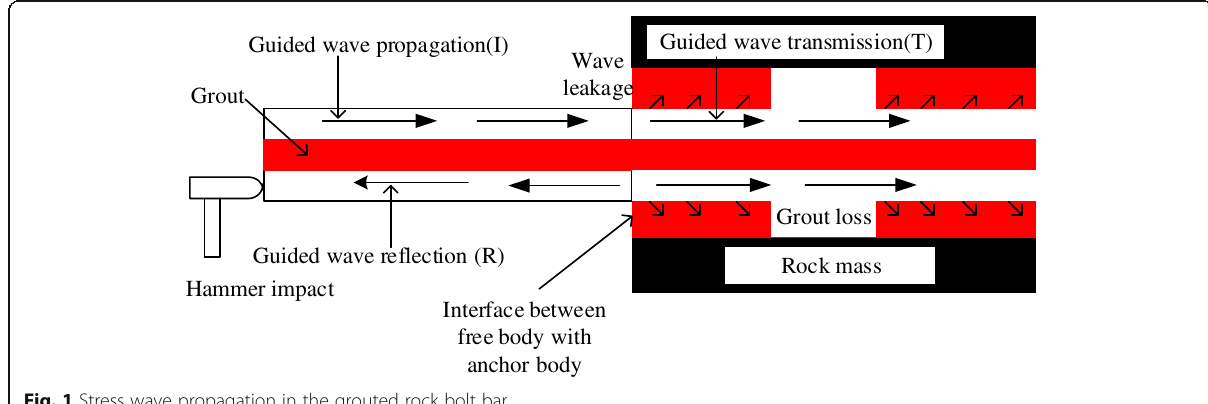
Fig. 1 Stress wave propagation in the grouted rock bolt